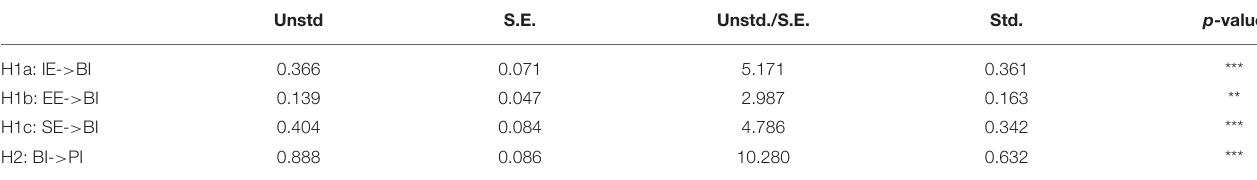
TABLE 4 | Regression coefficient.